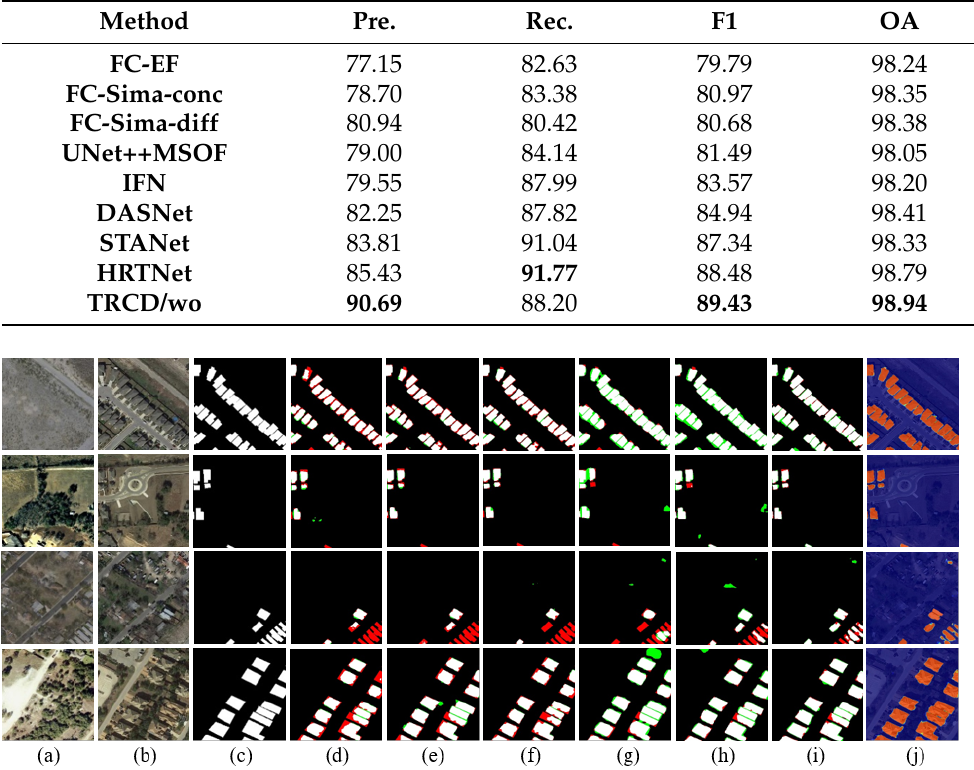
Figure 10. Qualitative comparison in terms of the detected changes from image t1 to image t2 on the LEVIR-CD dataset. TP is shown in white, TN is shown in black, FP is shown in green, and FN is shown in red: ( a ) prechange, ( b ) postchange, ( c ) ground truth, ( d ) FC-siam-diff, ( e ) UNet++MSOF, ( f ) IFN, ( g ) DASNet, ( h ) STANet, ( i ) our proposed model, and ( j ) attention